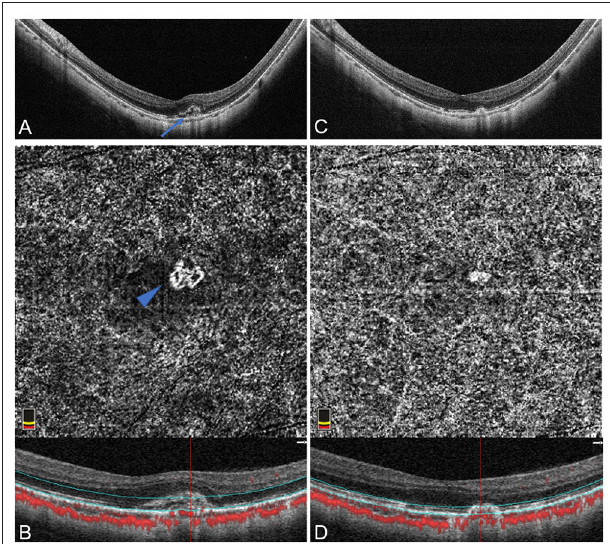
FIGURE 3 | Disorganized vascular loops pattern of active mCNV imaged by OCT and OCTA before and after anti-VEGF injection in Patient # 8, a 51-year-old man (axial length 29.84mm) in the left eye. OCTA segmentation was manually adjusted to acquire a clear en face image visualizing the entire thickness mCNV lesion. (A) Spectral-domain OCT B-scan at baseline showed a small hyper-reflective type-2 CNV (blue arrow) beneath the neurosensory retina with fuzzy ellipsoid zone and discontinuous RPE. (B) OCTA en face image (3 × 3mm) at baseline detected a small disorganized vascular loop-like lesion with unobvious capillary ramifications, suggesting an immature network (blue arrowhead). (C) One month after the first injection, OCT image revealed narrowing of mCNV lesion with a relatively clear ellipsoid zone. (D) One month after the first injection, OCTA en face image (3 × 3mm) indicated an absence of vascular details due to the obviously attenuated mCNV lesion. The lower parts of image (B,D) represented the cross-sectional structural OCT images corresponding to the upper OCTA en face images, respectively, displaying the boundaries (green lines) of the OCTA slabs after manual adjustment of